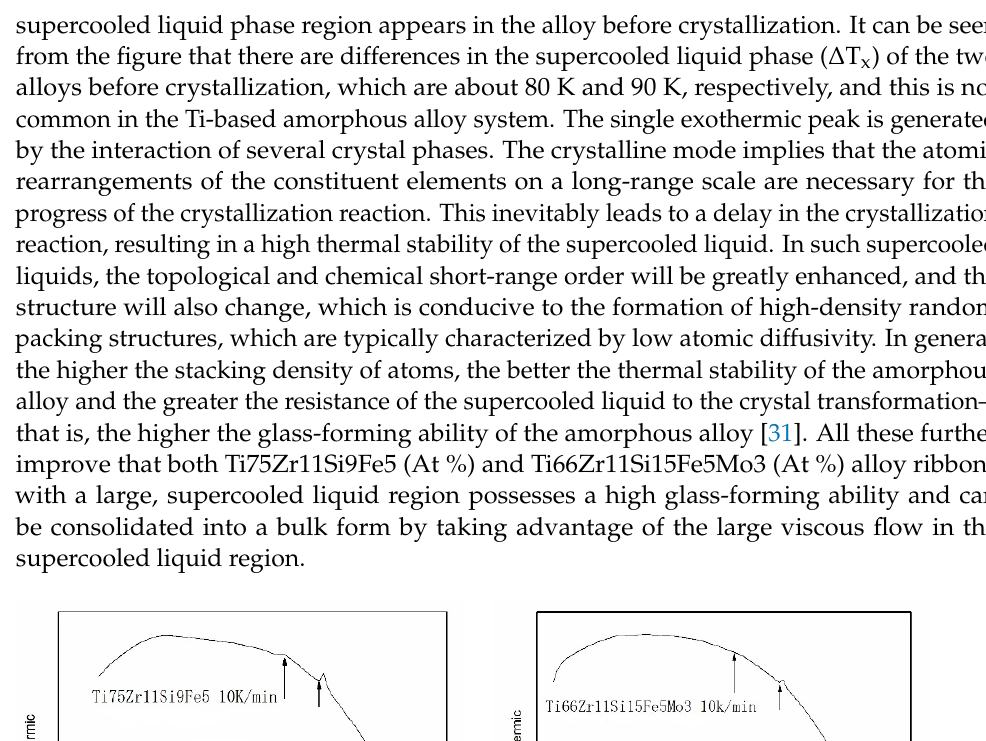
( b ) Figure 3. TEM morphology of Ti75Zr11Si9Fe5 (At %) and Ti66Zr11Si15Fe5Mo3 (At %): ( a ) Ti75Zr11Si9Fe5 (At %) and ( b ) Ti66Zr11Si15Fe5Mo3 (At %).